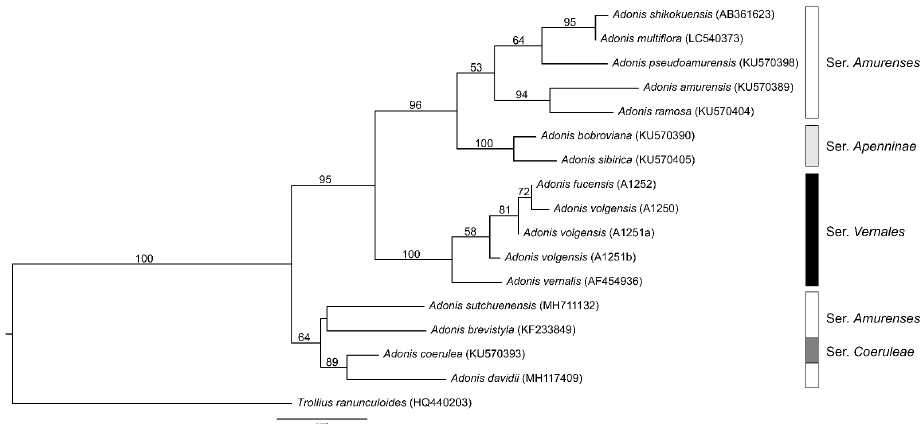
Figure 5. Neighbor-joining tree of 15 accessions of Adonis sect. Adonanthe based on nrDNA ITS sequence variation and Kimura-2-parameter distances. GenBank accession numbers and probe numbers of the present study ( A. fucensis , A. volgensis ) are given in brackets. Numbers above branches are bootstrap values based on 1000 replicates.